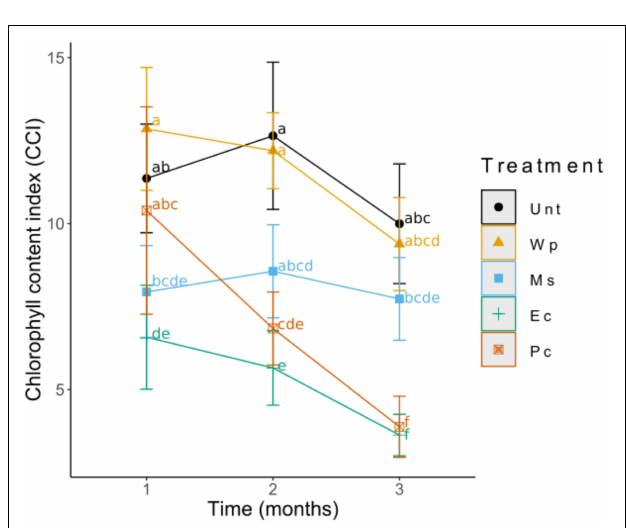
FIGURE 4 | Changes in the chlorophyll index of birch leaves during the 3-month growth period. Analyses were performed using the 3rd most developed leaf of each treatment and measured by a CCM-200 plus chlorophyll meter. Values shown represent (means ± SD) the results of 12